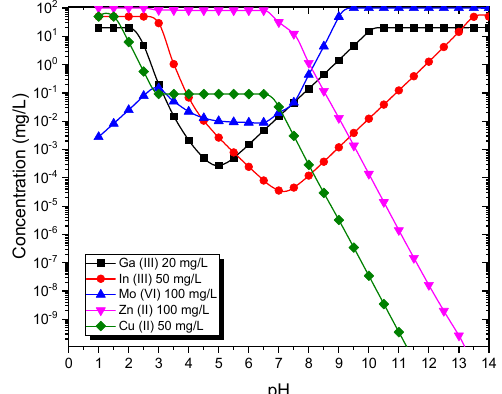
Figure 1. Solubility of Ga, In, Mo, Zn and Cu vs. pH obtained by Visual Minteq. Preliminary experiments were carried out using synthetic solutions of In (100 mg/L), Ga (100 mg/L) and Mo (200 mg/L). All metal leaching and recovery experiments were repeated twice. For In extraction recovery, the solvent extraction parameters were the fol-